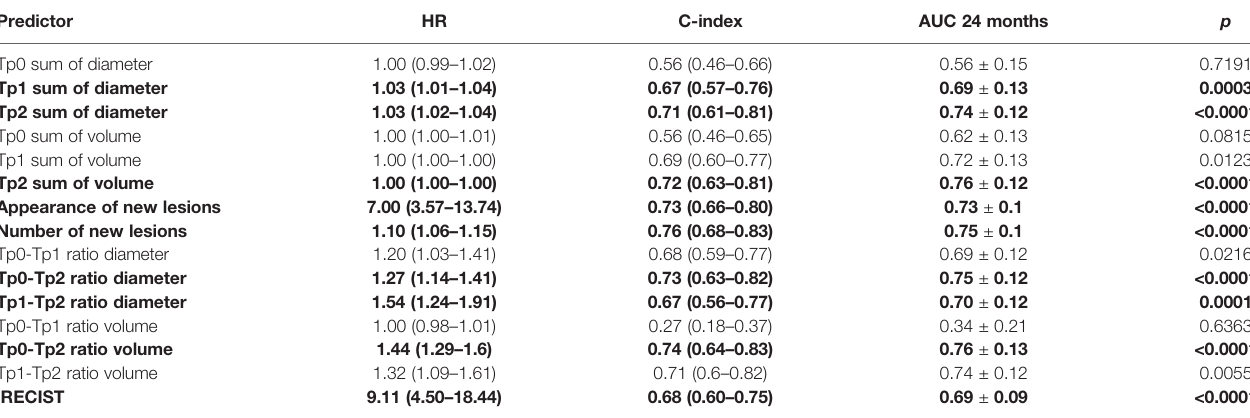
TABLE 3 | Results from univariate Cox proportional hazard regression on imaging biomarkers with hazard ratio (HR), C-index, AUC at 24 months and p -values. Parameters statistically signi fi cant at FWER=0.05 are in bold.